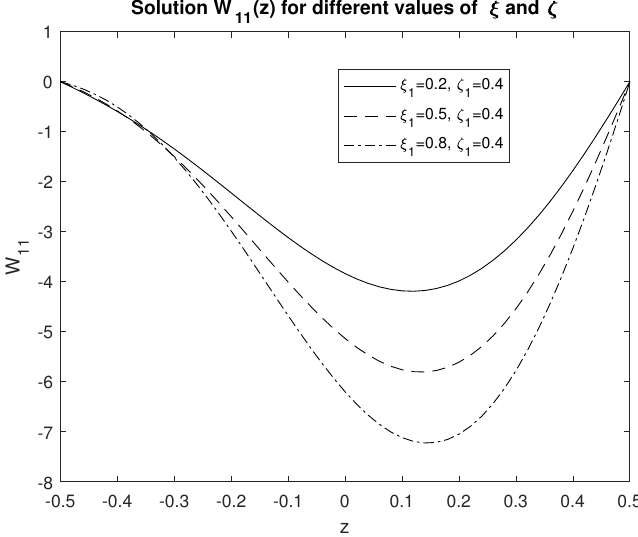
Figure 2. Solutions W 11 ( z ) for positive ξ 1